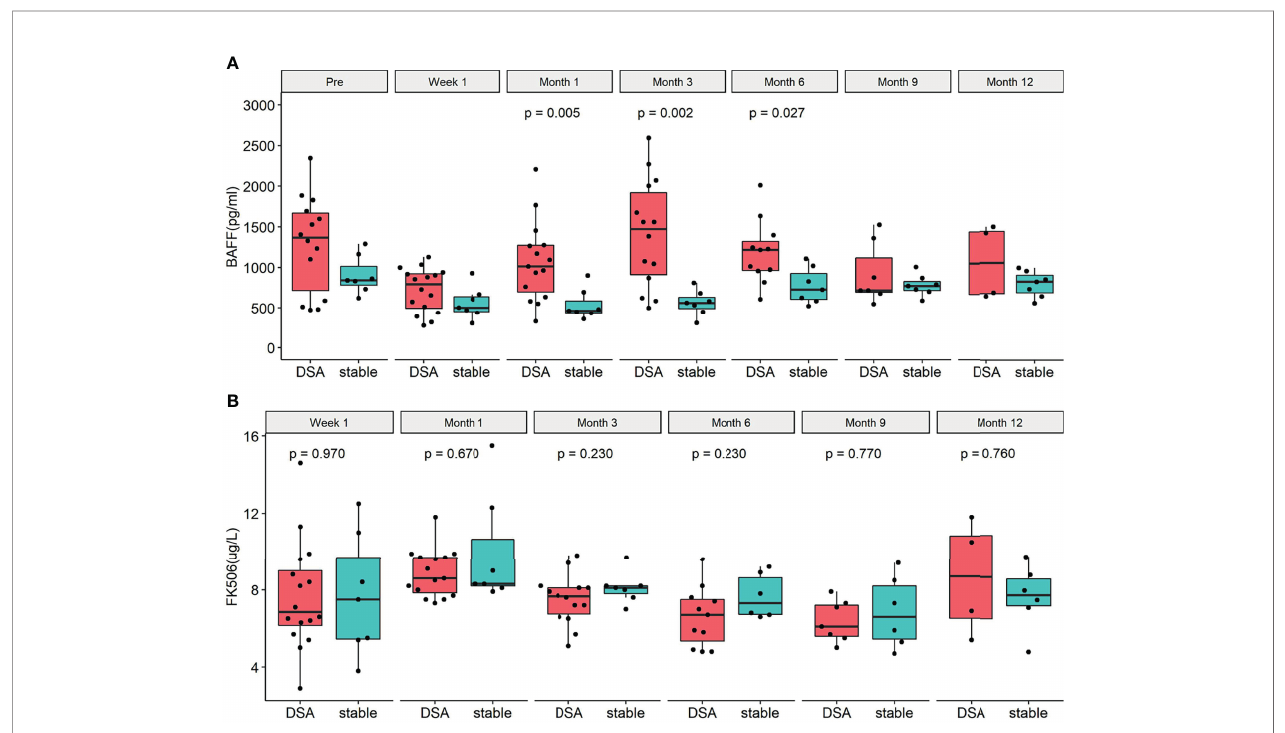
FIGURE 4 | The dynamic changes of serum B cell-activating factor (BAFF) levels and tacrolimus concentration in the donor-speci fi c antibody (DSA) group and the stable group before the occurrence of DSA. (A) Dynamic changes of BAFF levels in the DSA group and the stable group. There were signi fi cant differences between the two groups at 1 month ( P = 0.006), 3 months ( P = 0.003), and 6 months ( P = 0.033). (B) Dynamic changes of tacrolimus concentration in the DSA group and the stable group. There was no signi fi cant difference between the two groups at different time points [W1: 6.9 (6.2, 9.0) pg/L vs. 7.5 (5.5, 9.7) pg/L, P = 0.947;